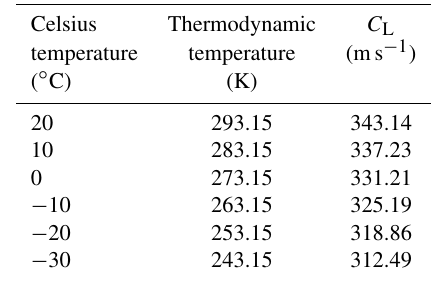
Table 1. Estimated Lamb wave velocities in an isothermal tropo- sphere